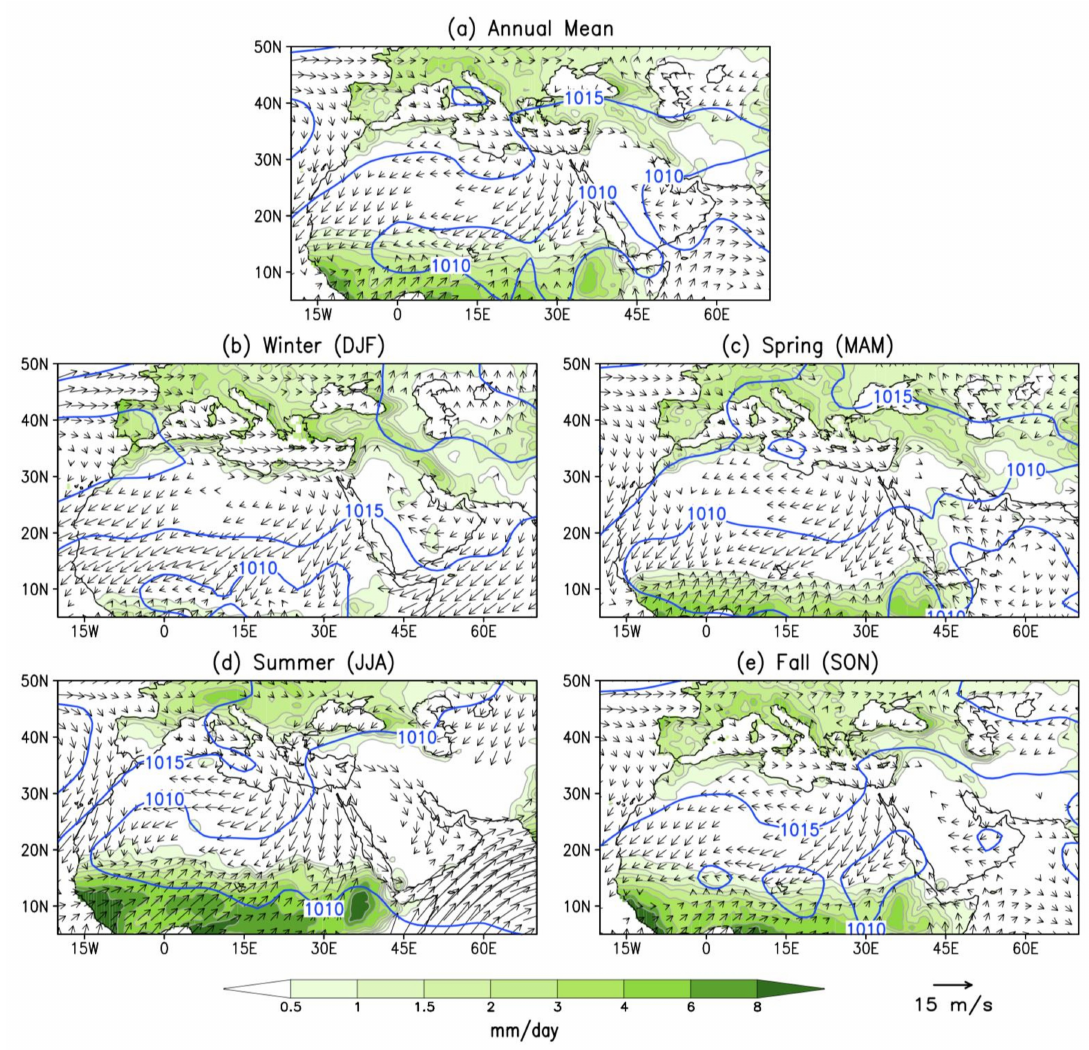
Figure 5. The climatological precipitation (in green contours, mm / day) from Global Precipitation Climatology Centre (GPCC) ver. 8, the mean wind vector field at 925-hPa (black arrows, m / s) and the mean sea level pressure (blue contours, hPa) from NCEP Reanalysis, shown ( a ) annually, and ( b – e ) for each individual season. The period of analysis is